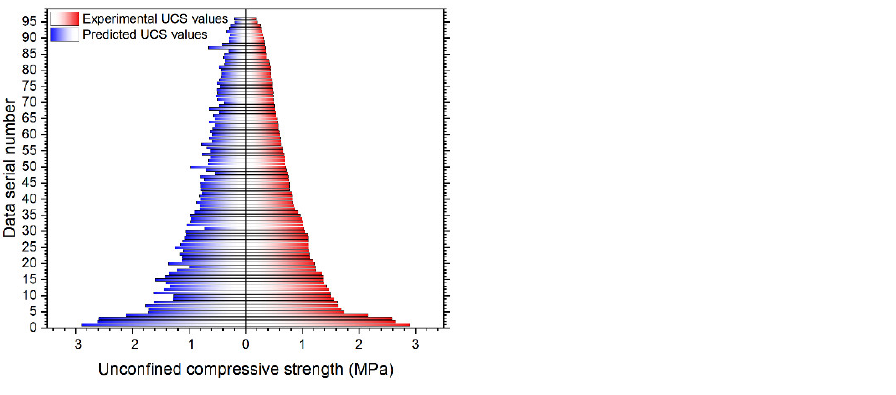
Figure 11. Comparison of UCS values obtained from the experimental investigation and P&S model prediction.